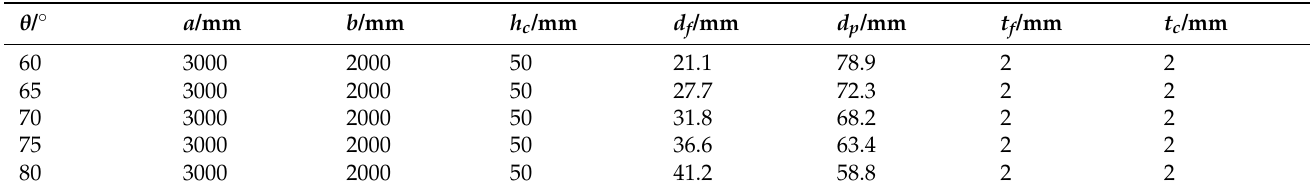
Table 10. Geometric parameters of the U-type sandwich panel with different angles.